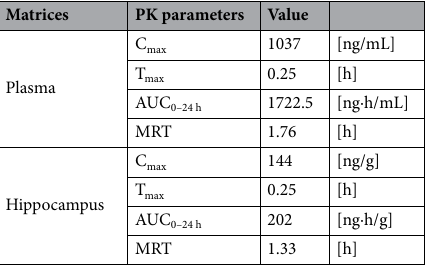
Table 1. Pharmacokinetic (PK) parameter of T-518 in C57BL mice at 3 mg/kg, po. Data are expressed as mean. n = 5.